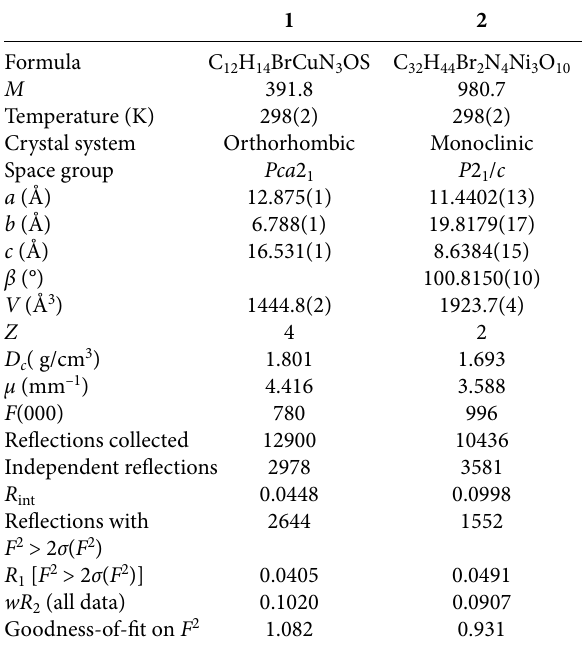
Table 1. Crystal data and structure refinement parameters for com- plexes 1 and